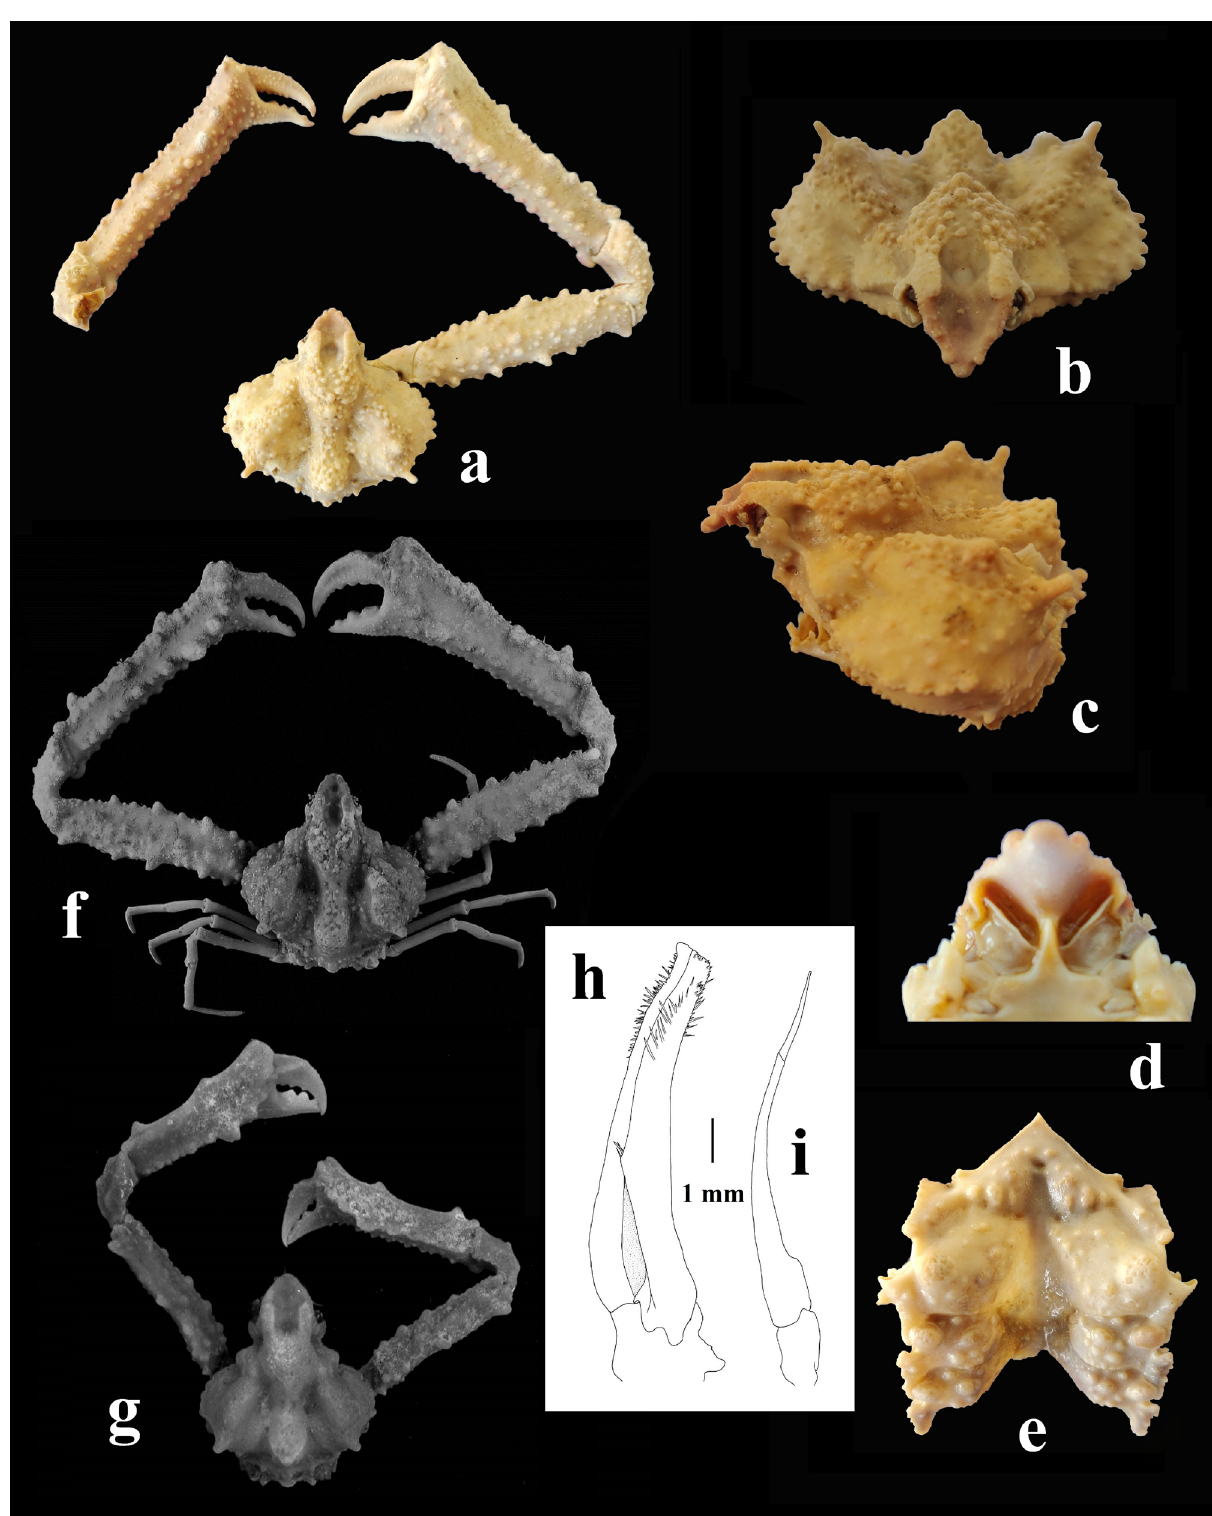
Figure 1. Rhinolambrus lippus (Lanchester, 1901), male (LFSC.ZRC-108), CL 41 mm CW 44 mm: a, Dorsal view; b, carapace front view; c, carapace lateral view; d, frontal projection lower view; e, sternum. Lambrus lippus Lanchester, 1901, male, (MHNH), CL: 37.1 mm; CW: 39.7 mm: f, Dorsal view. Lambrus ( Rhinolambrus ) montiger Nobili, 1905, holotype (MNHN-IU-2014-7824), juvenile female, CL 9.5mm CW 9.7 mm: g, Dorsal view. Rhinolambrus lippus, male (MNHN), CL 37.1 mm CW 39.7 mm: h, G1; i, G2 (after Tan, 2004: fig. 130J,